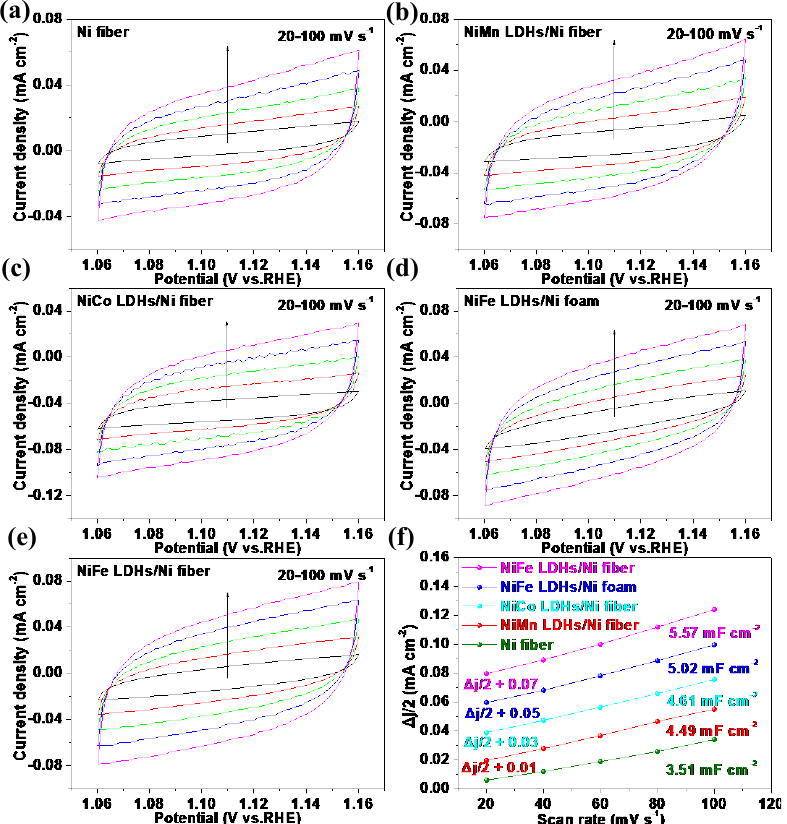
Figure 6. CV curves of Ni fiber ( a ), NiMn LDHs/Ni fiber ( b ), NiCo LDHs/Ni fiber ( c ), NiFe LDHs/Ni foam ( d ), and NiFe LDHs/Ni fiber ( e ) in the double-layer region at scan rates of 20, 40, 60, 80, and 100 mV s −1 in 1 M KOH; the C dl of ( f ) determined by the plots of Δj/2 = (j a − j c )/2 as a function of the scan rate for with different shells. j a represents the anode current density, j c represents the cathode current density.